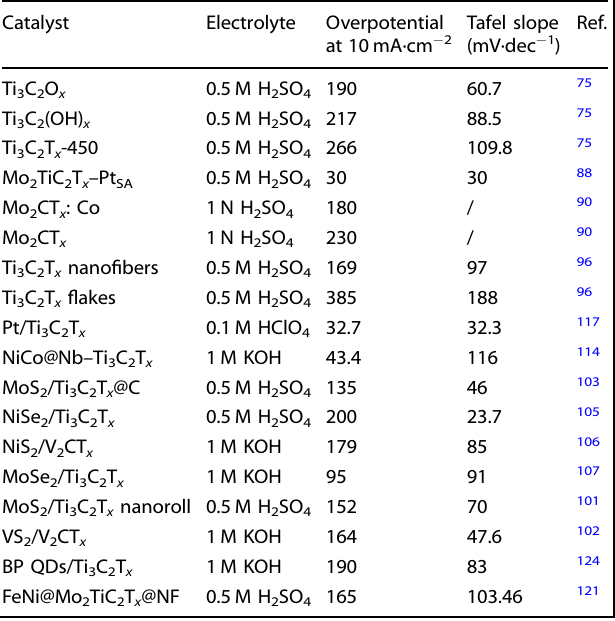
Table 2. Summary of HER activities of MXene-based electrocatalysts. Catalyst